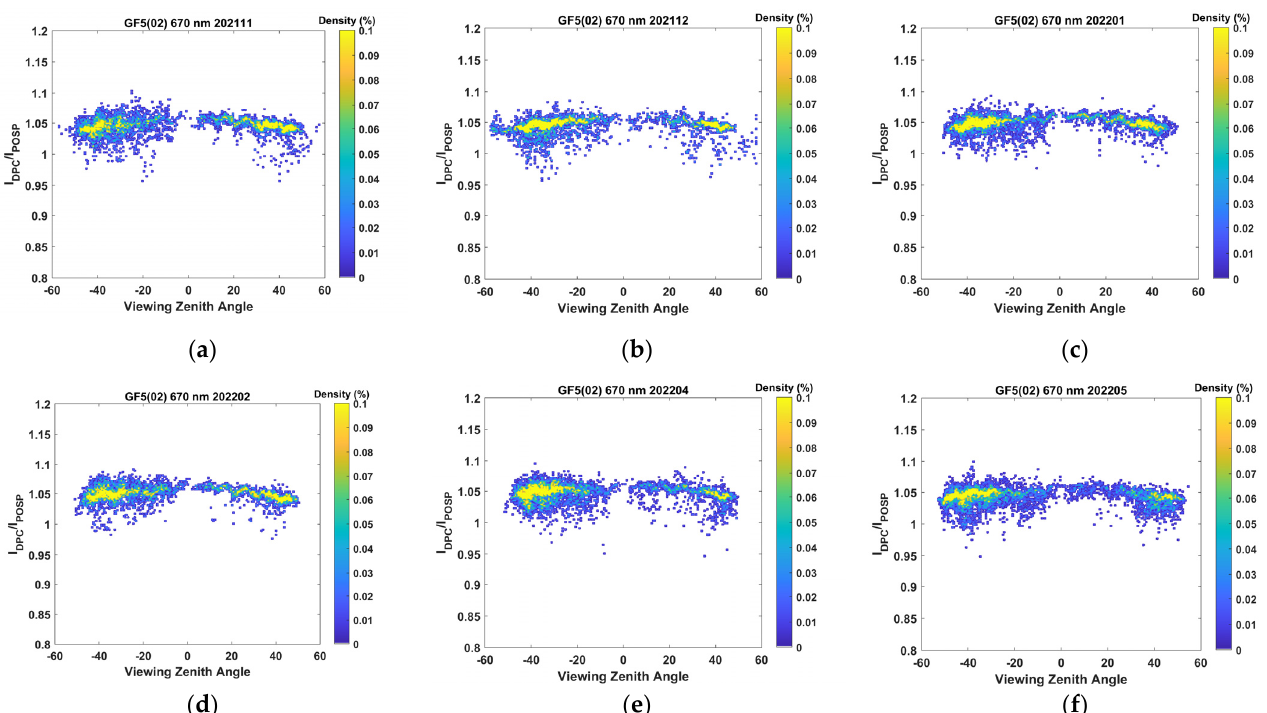
Figure 11. The ratio of DPC to POSP normalized radiance in the 670 nm band with different VZAs. These data pairs are selected for collection from ( a ) November 2021; ( b ) December 2021; ( c ) January 2022; ( d ) February 2022; ( e ) April 2022; and ( f ) May 2022 in DPC and POSP Level 1 products.